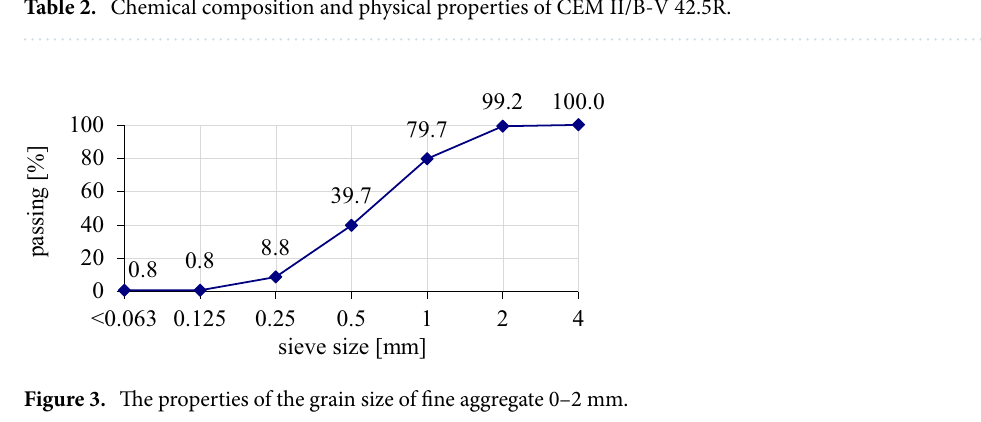
Table 2. Chemical composition and physical properties of CEM II/B-V 42.5R.